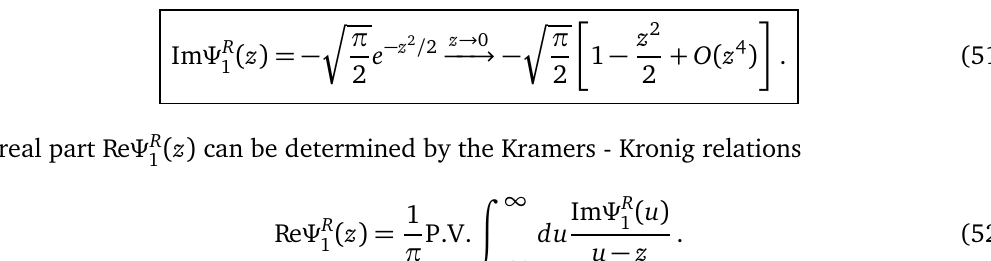
( z )] (red curve), Im [ Ψ R 1 ( z )] (blue 1